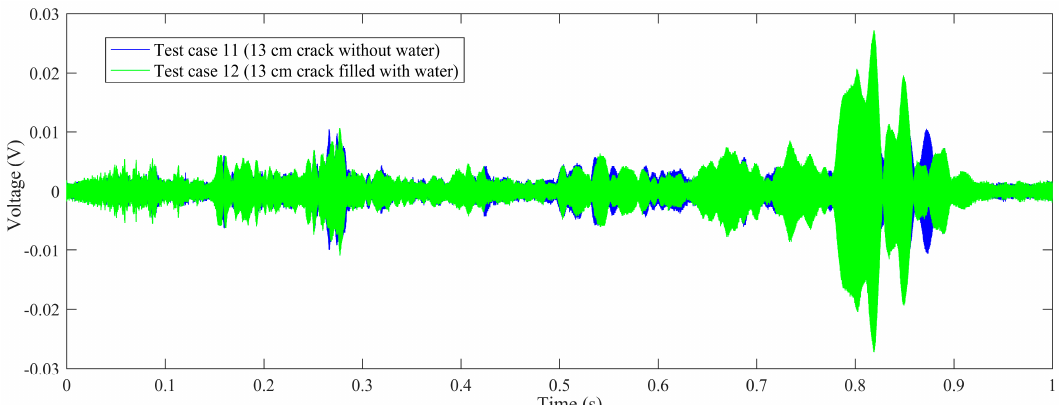
Figure 8. The comparison of voltage signals: test case 11 (13 cm crack without water), test case 12 (13 cm crack filled with water).